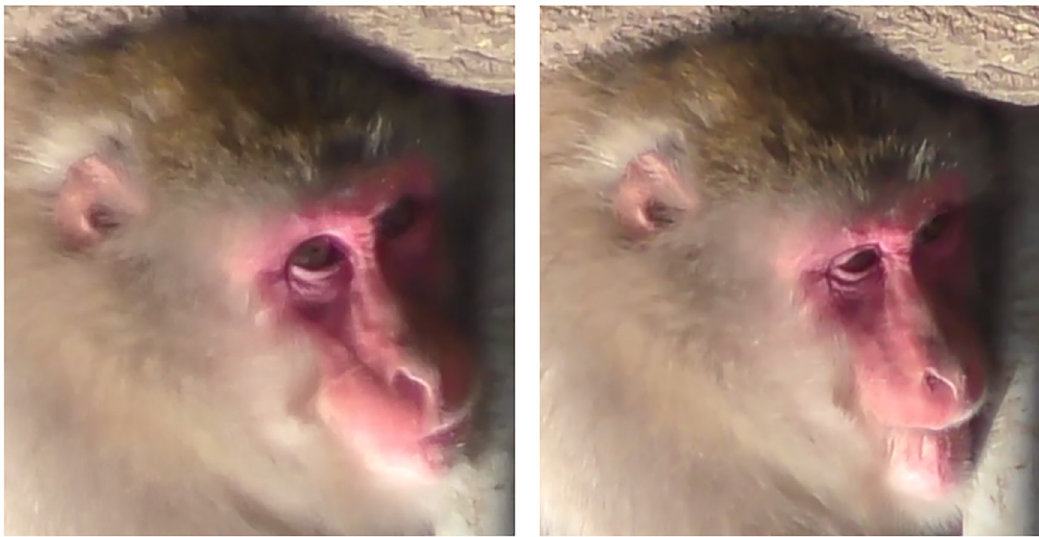
Fig 6. Left: Neutral lower face; Right: AU8 + AU18 +AU26, acting simultaneously with appearance changes from both AUs, namely stretched lower lip (AU8) and wrinkling of lower lip